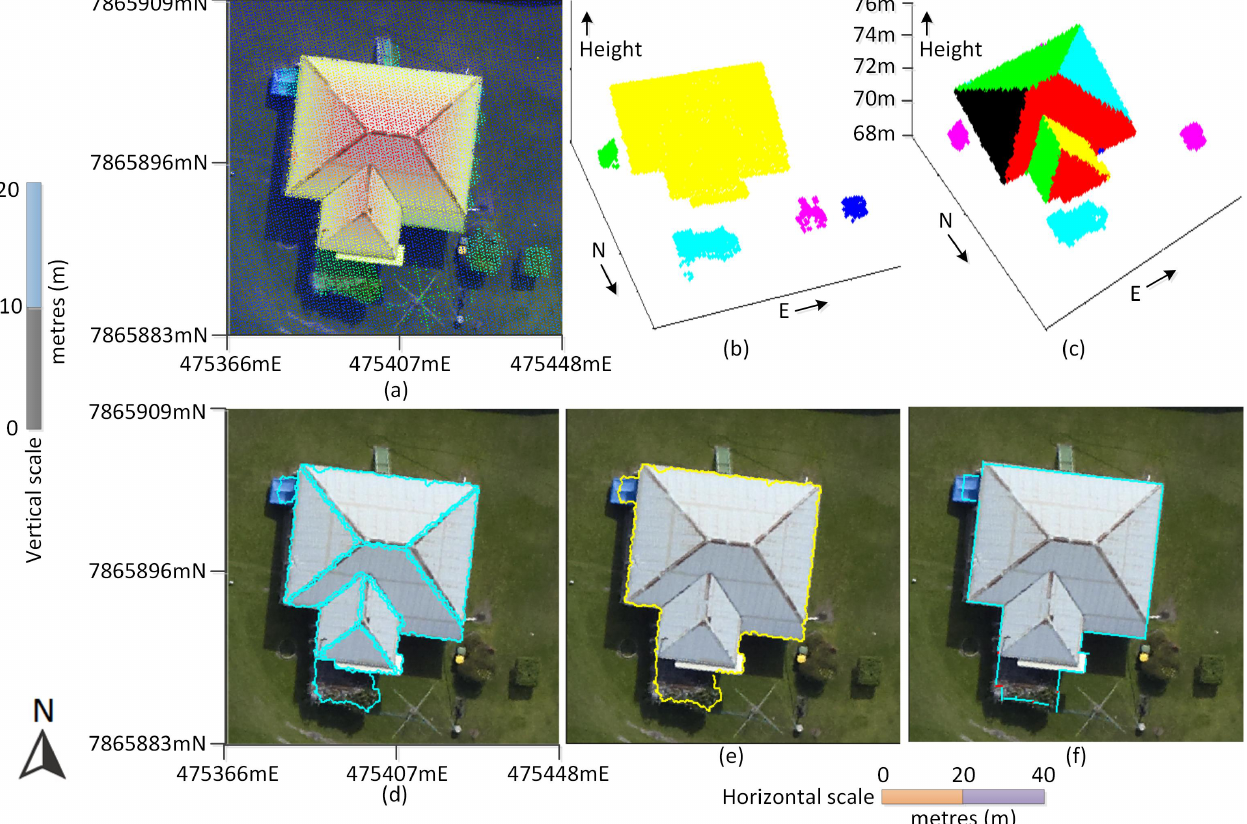
Figure 2. Building detection from point cloud data: ( a ) input point cloud overlaid on an aerial image; ( b ) non-ground point cloud data (3D view), where point clusters are shown in different colours; ( c ) extracted planar roof segments (3D view); ( d ) plane boundaries of the finally chosen planar segments; ( e ) building boundary; and ( f ) regularised building